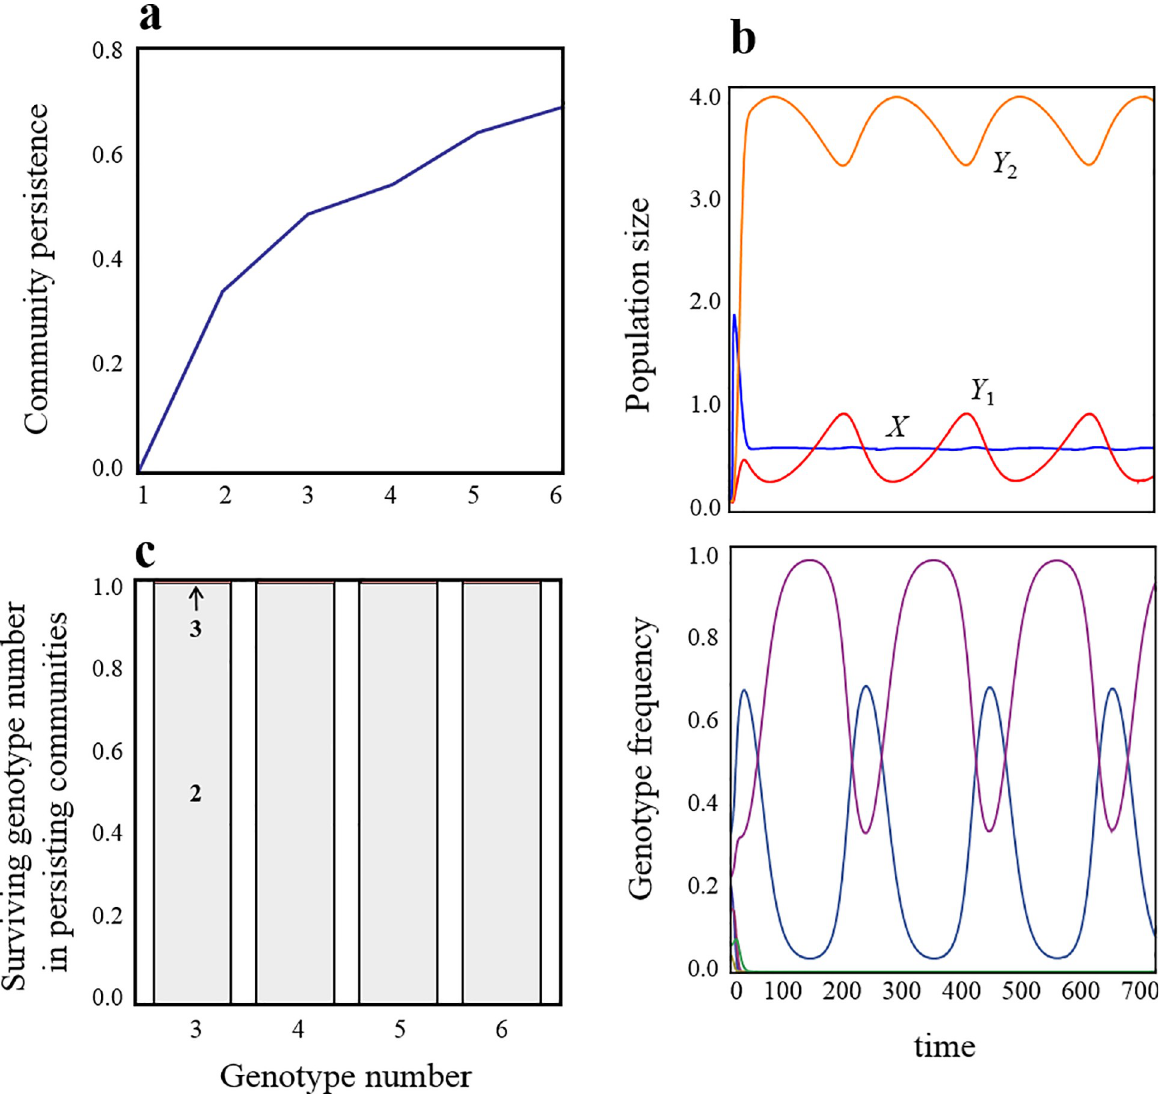
Fig 1. Eco-evolutionary dynamics and its consequences on coexistence: (a) Effects of genotype number on community persistence (see below). (b) Typical dynamics between population size and genotype frequency. (c) Surviving genotype number in persisting communities. Community persistence is the probability that all species persist during a sufficiently long period. It was calculated by measuring the frequencies of all co- > 10 − 5 for all i ) after sufficiently long periods (t = 5 × 10 3 by which time community persistence reaches an asymptote) in occurring species ( X , Y i 500 runs. In addition, surviving genotype number in persisting communities was calculated and the proportion of different numbers of surviving genotypes was plotted in (c) (2 or 3). In each iterated simulation, initial species abundances, genotype frequencies, and a ij are randomly chosen from a uniform distribution, U(0, 1). Parameter values are r = 2.0, K = 2.0, g = 0.5, and d = 0.1. The parameters a used in (b) are shown in S1 i i i ij